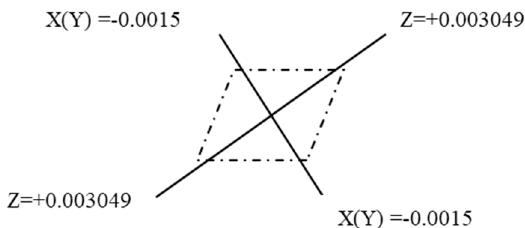
Figure 1. Charge distribution of quadrupole moment of Fe-Zr molecule.